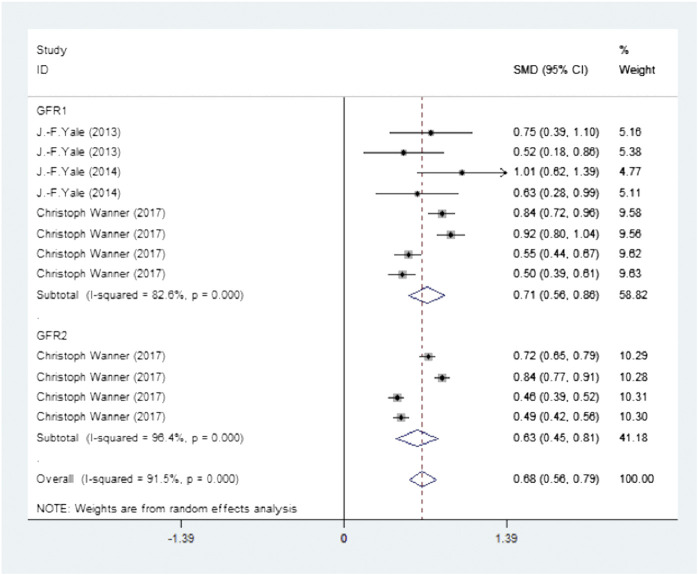
Meta-analysis and the forest plot data of hemoglobin levels in the subgroup analysis.